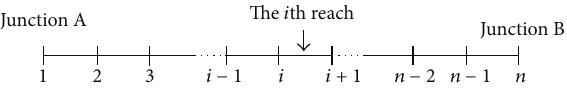
Figure 1: Illustration of the flow on grid and network